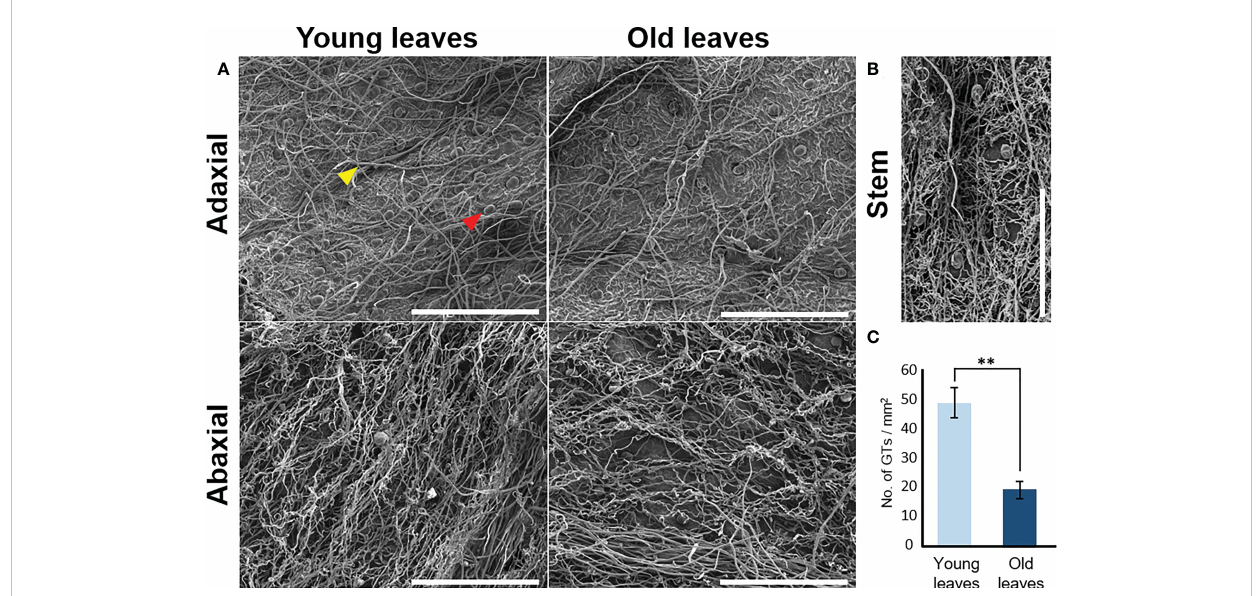
FIGURE 2 Micromorphology of trichomes of Artemisia argyi . (A) Distribution of trichomes on adaxial and abaxial surfaces of young and old leaves using a scanning electron microscope. Red triangle indicates glandular trichome and yellow triangle indicates non-glandular trichome. Scale bars: 500 m m. (B) Distribution of trichomes in the stem. Scale bars: 500 m m. (C) Glandular trichome (GT) density difference on adaxial surface between young and old leaves. Statistical differences were examined by two-tail method of unpaired Student ’ s t-test ( n =3). Symbols denote statistical signi fi cance